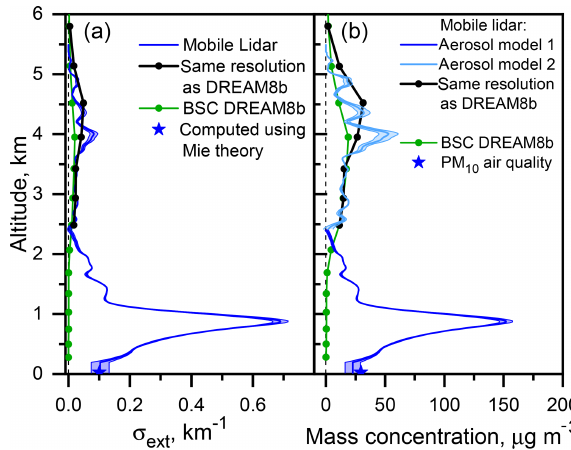
Figure 10. Comparison of (a) extinction coefficient and (b) mass concentration mean profile at Lille, 15:30UTC from mobile lidar–sun-photometer measurements (532nm) (blue) with BSC- DREAM8b mean dust extinction and concentration at 550nm (green). Data points from mobile measurements in the range 2.5– 5km are reduced to the model resolution (black) for comparison with the simulated dust